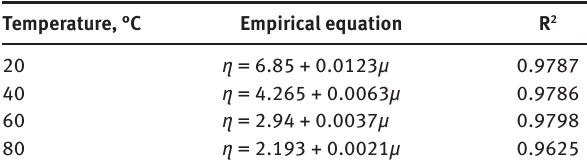
Table 5: The empirical equation for kinematic viscosity and conductivity of biodiesel.